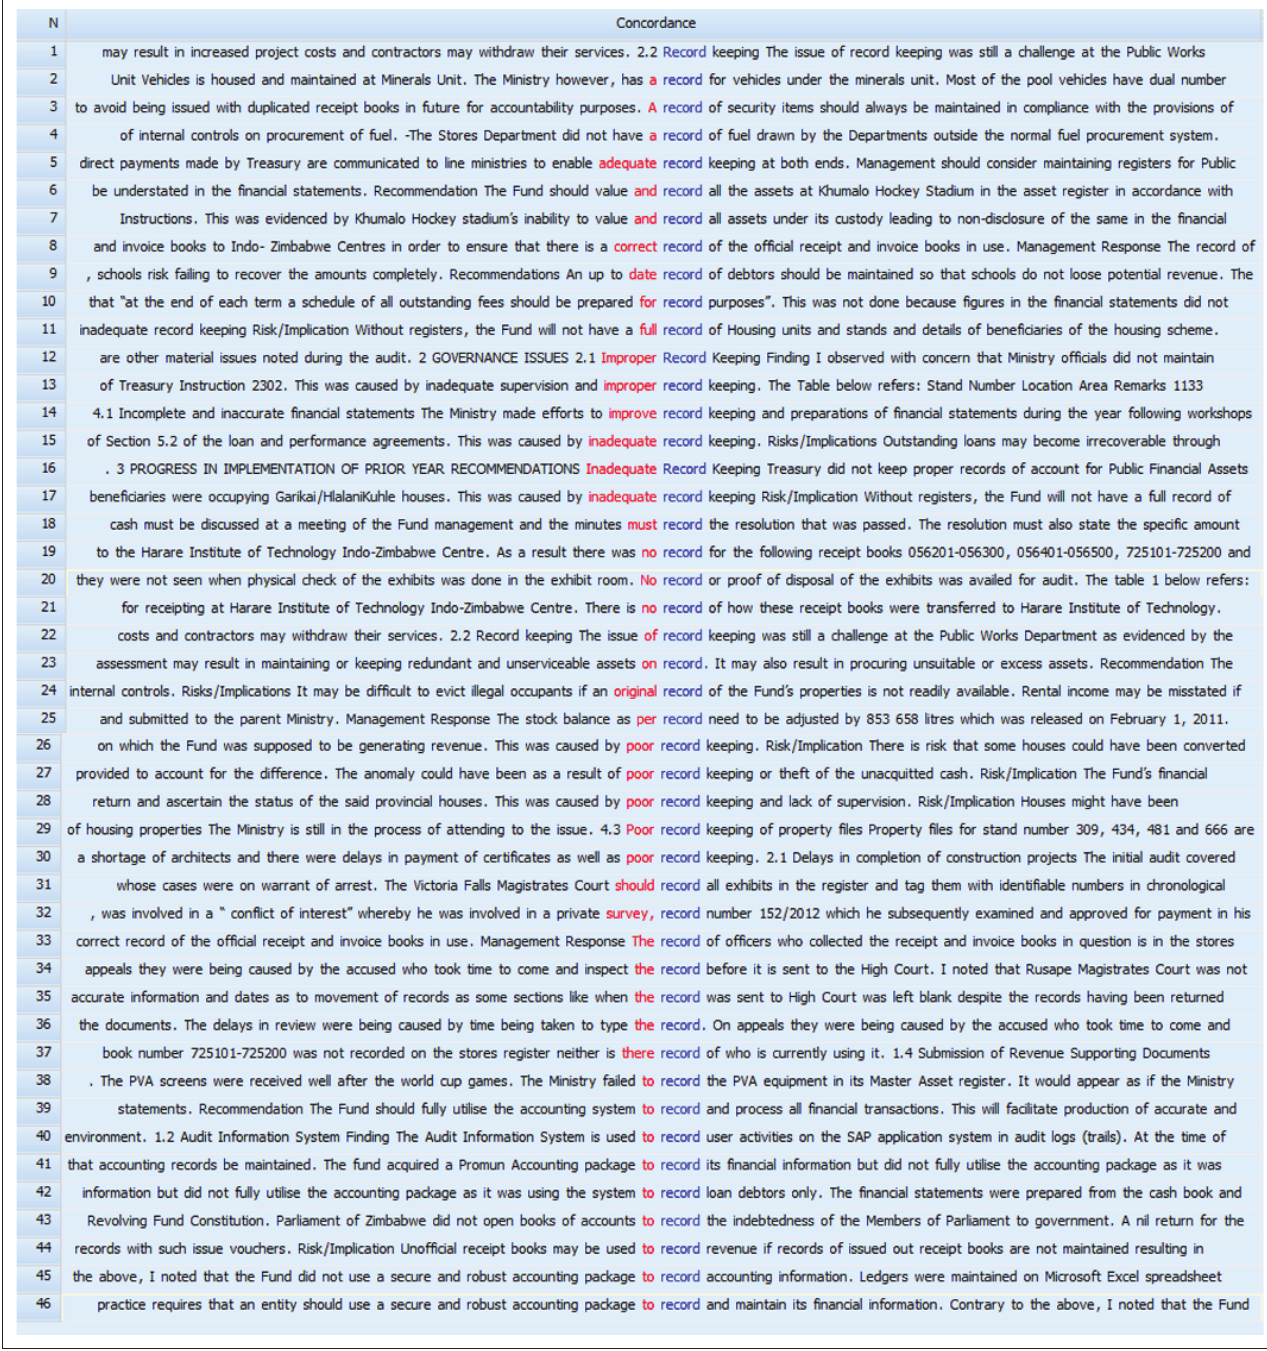
FIGURE 6: The Comptroller and Auditor General of Zimbabwe Narrative Report for the financial year ended 31 December 2014 for appropriation accounts and miscellaneous